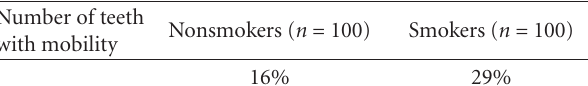
Table 6: Comparison of mobility between nonsmokers and smokers.